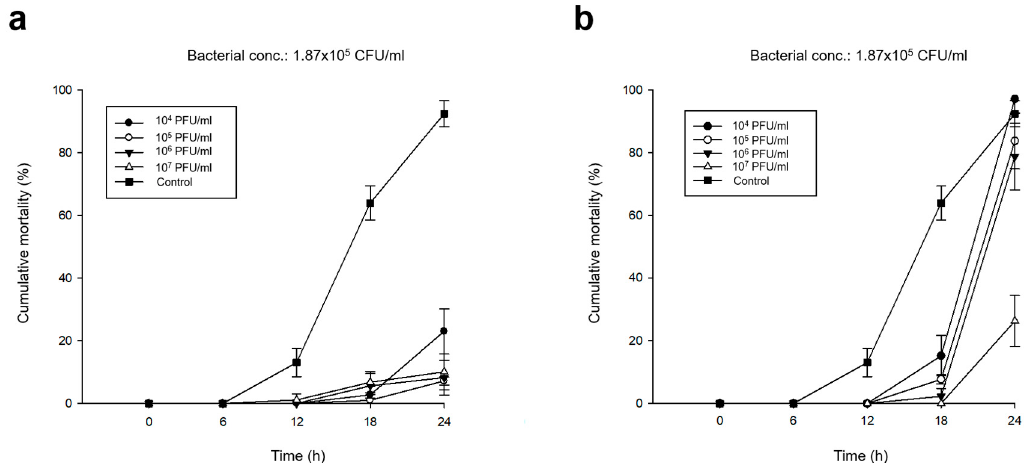
Figure 4. Prophylactic efficacy of various concentrations of pVco-5 ( a , 1.25 × 10 n PFU/mL) and pVco-7 ( b , 1.44 × 10 n PFU / mL) against Vco58 (conc.: 1.87 × 10 5 CFU / mL) in Pacific oyster larvae. As a result of statistical analysis, all groups except the 10 4 PFU / ml of pVco-7 treated group at 24 h were shown p < 0.001 when compared with the control group.